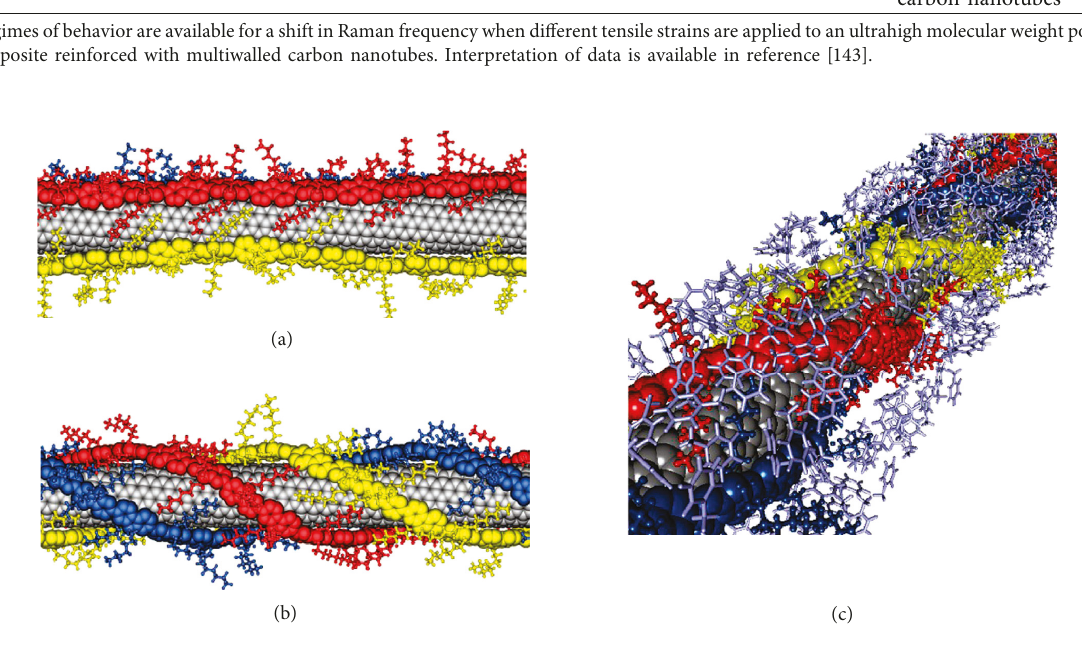
Figure 7: Single-walled carbon nanotube wrapped by three poly(9,9-dioctylfluorenyl-2,7-diyl) chains with different geometries: (a) polymer chains aligned to the axis of the carbon nanotube and (b) periodic helical conformation. The polymer chains are represented by different colors: red, blue, and yellow. (c) The side chains of the polymer covered by the solvent system that contains enough toluene molecules. The toluene molecules are represented by light gray (adapted with permission from reference [154]; copyright 2011, American Chemical Society).